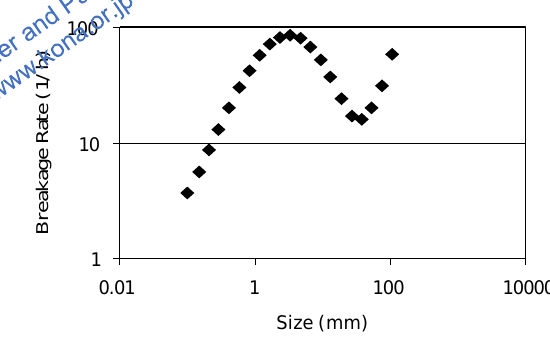
Fig. 2 Breakage Rate Distribution as Obtained by